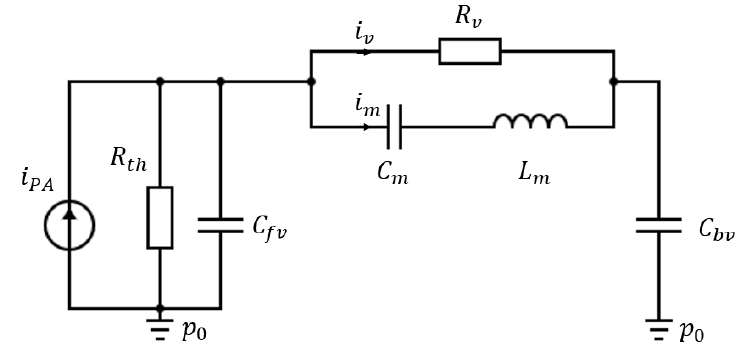
Figure 8. Complete equivalent electrical circuit of the PA sensor with (from left to right) the current source and the front volume, the acoustic slit with a velocity flow i v and the mechanical diaphragm with a velocity flow i m and, finally, the back volume.